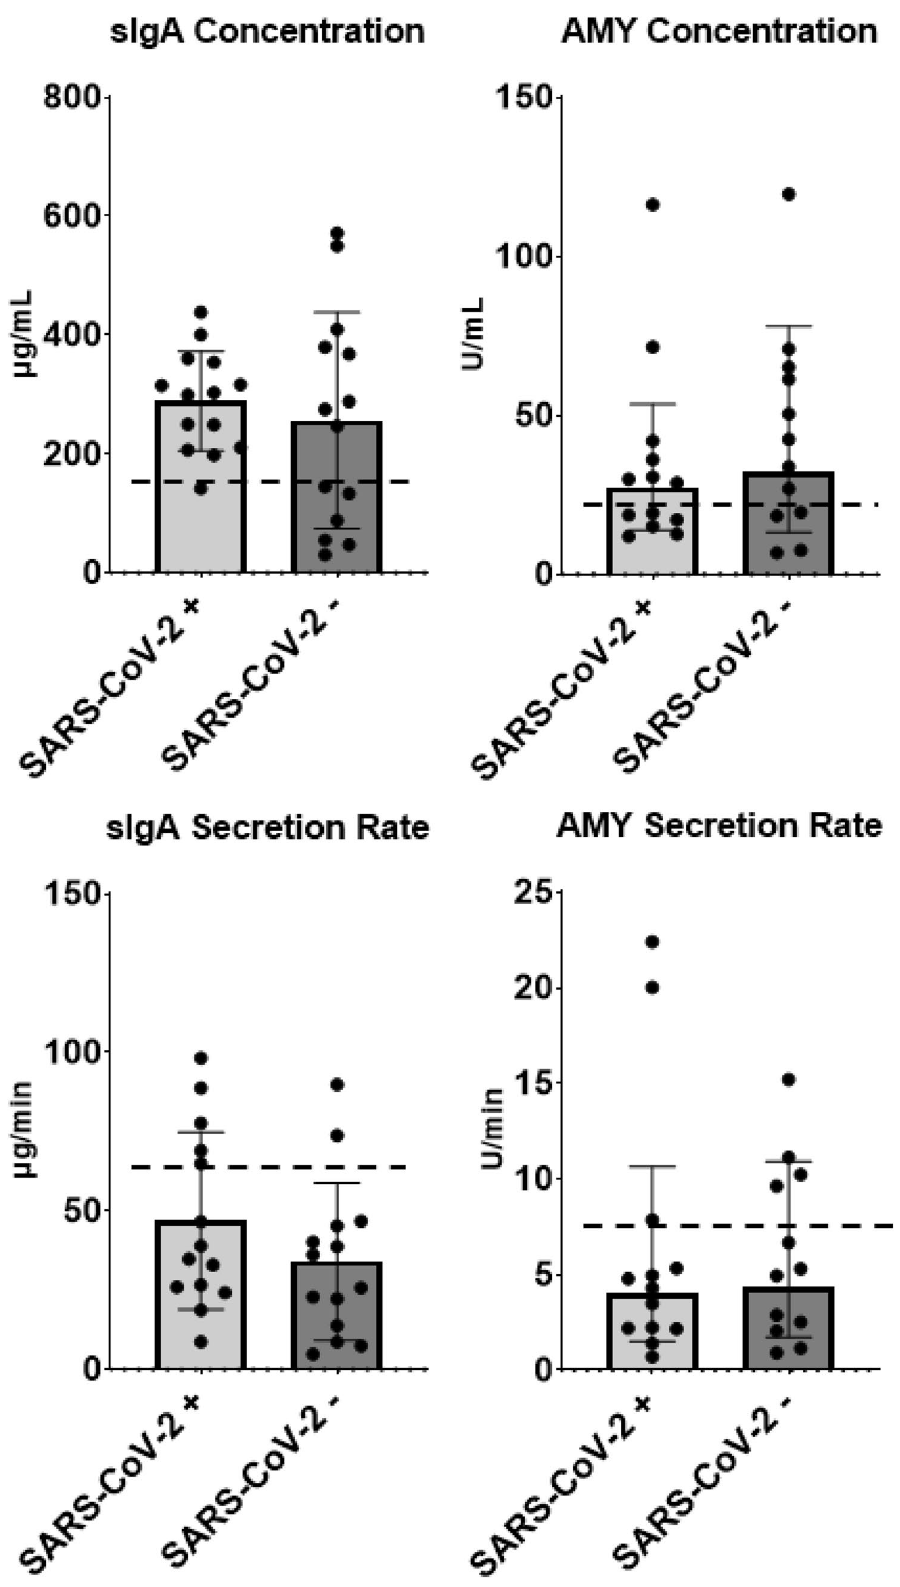
Figure 1. Concentrations and secretion rates of biomarkers of salivary immunity in athletes who had been infected with SARS-CoV-2 and those who had remained infection-free. No significant differences were found. Salivary IgA (SIgA), alpha- amylase (AMY), dash line (–) represents normal values reported in elite athletes. Concentrations and secretion rates for sIgA (n SARS-CoV-2 + = 14; n SARS-CoV-2- = 14) are presented as means ± S.D while alpha-amylase (n SARS-CoV-2 + = 13; n SARS-CoV-2- = 12) are presented as geometric means ±